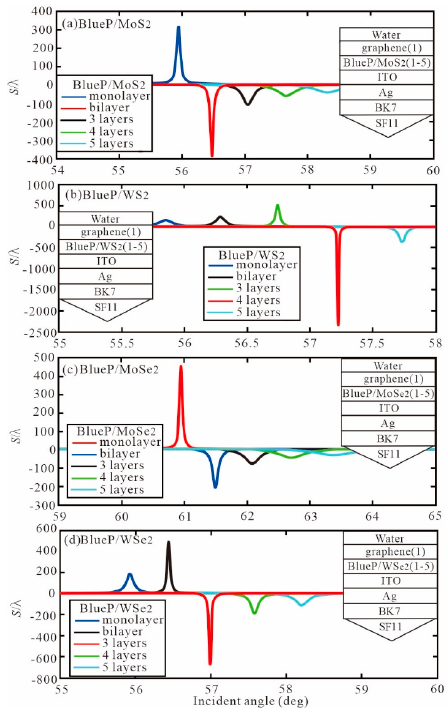
Table 4. The optimal GH shift (S/ λ ) with BlueP/TMDCs monolayer and different number of graphene.